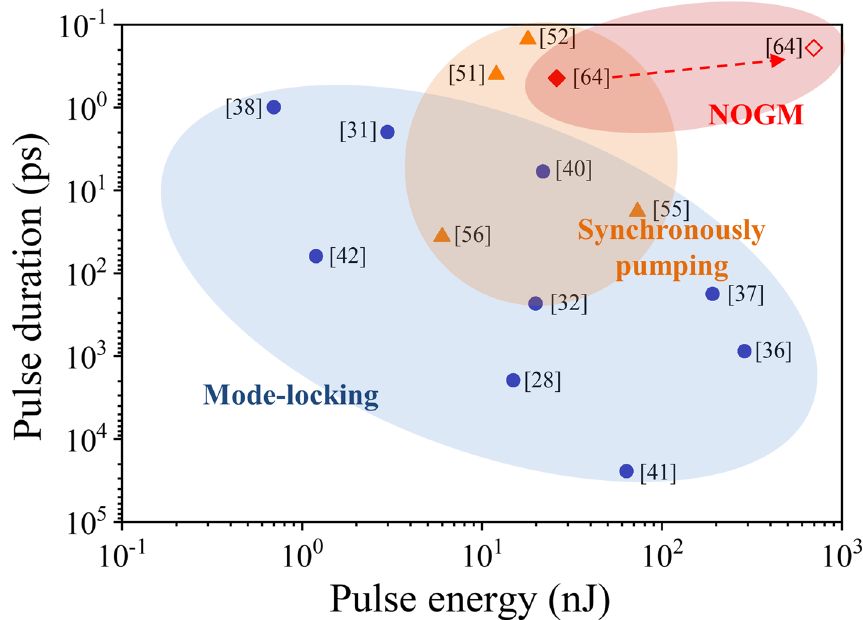
Fig. 15 Summary of the pulse energy and duration of the reported Raman fiber lasers, including mode-locking (blue circles), synchronously pumping (orange triangle) and NOGM (red diamond). The corresponding reference numbers of each work are marked